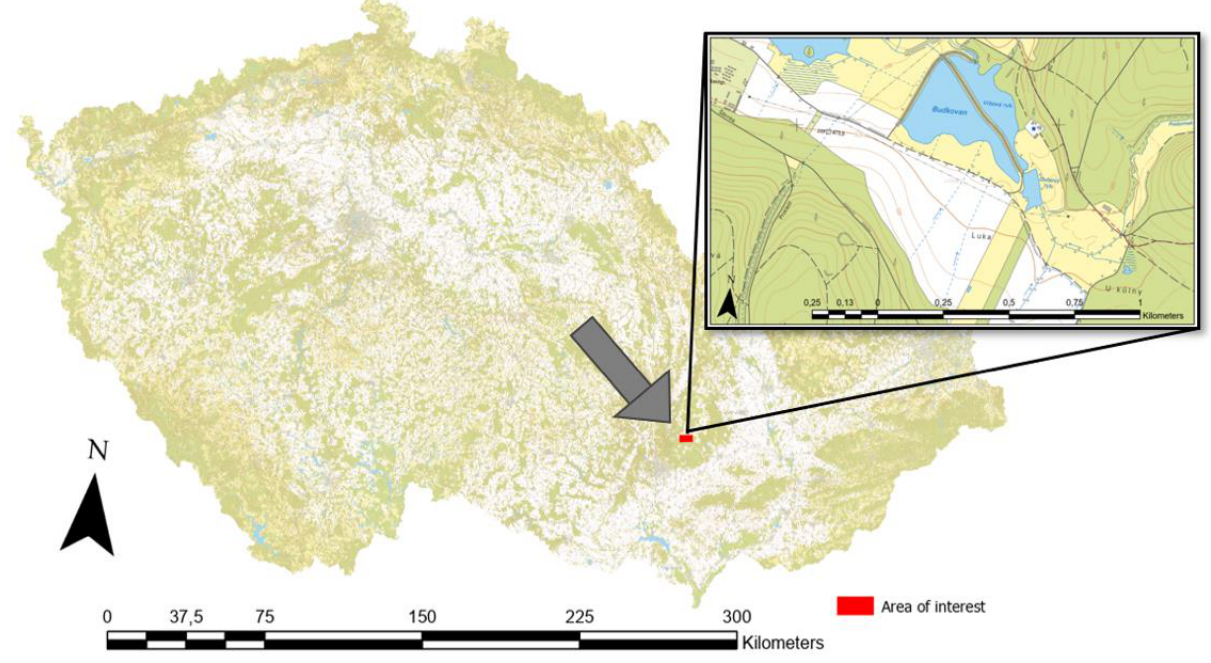
Figure 1. Area of interest within the Czech Republic, source [46].